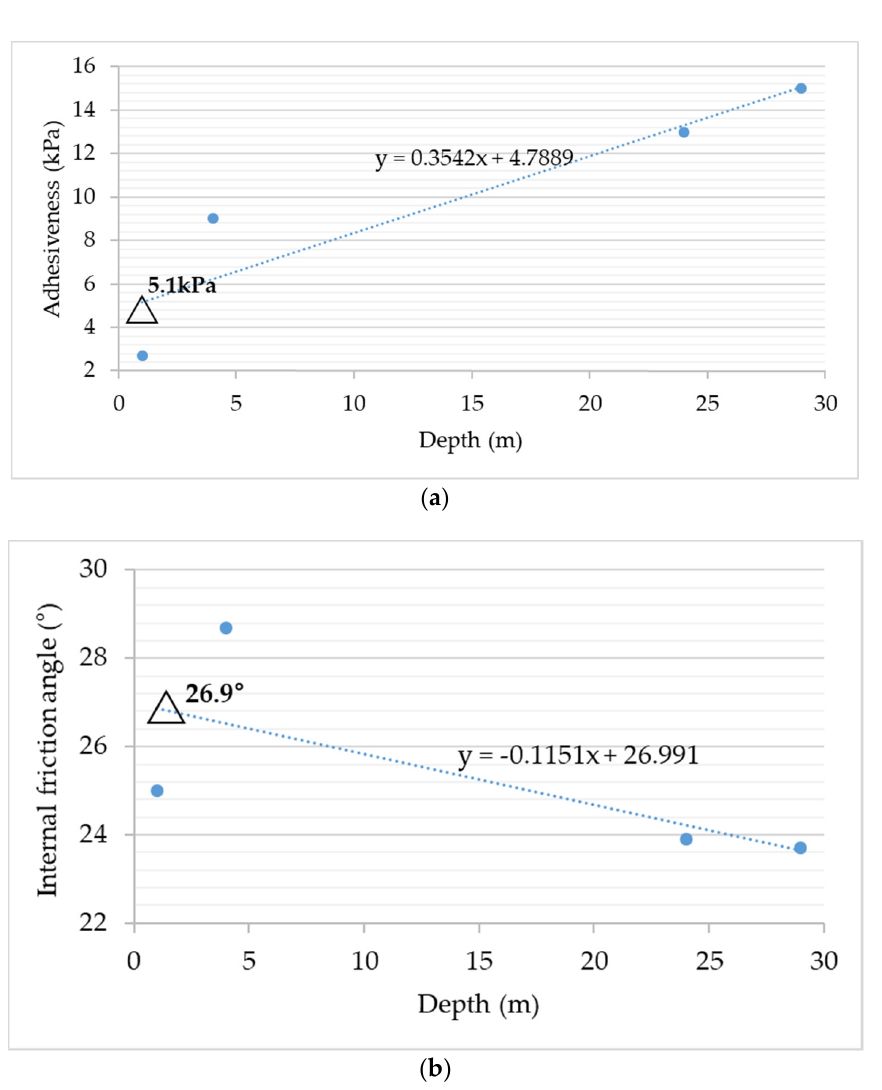
Figure 6. Test results of cohesion and friction angle through the shear and tri-axial compression test. ( a ) Cohesion according to depth; ( b ) internal friction angle according to depth. Table 3. Estimated values of physical properties of the ground.